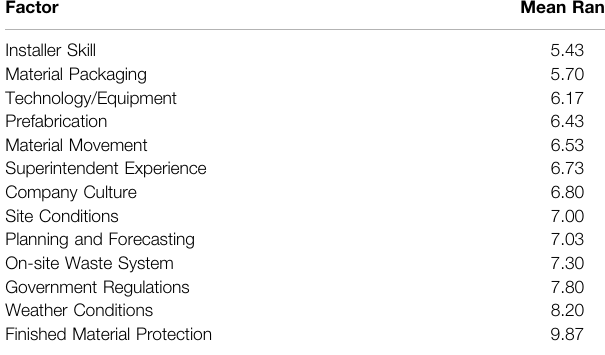
TABLE 8 | Mean ranks of the factors: juniors ’ responses.